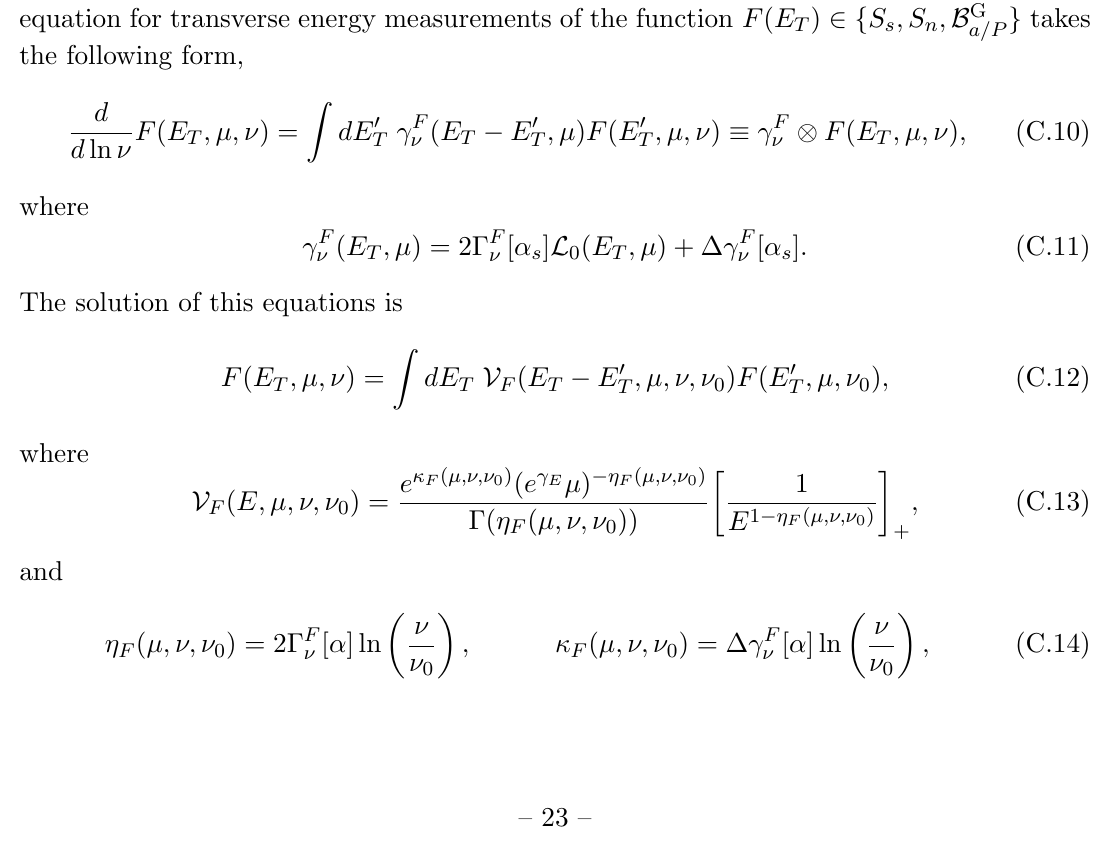
where r = (cid:11) ( (cid:22) ) =(cid:11) ( (cid:22)